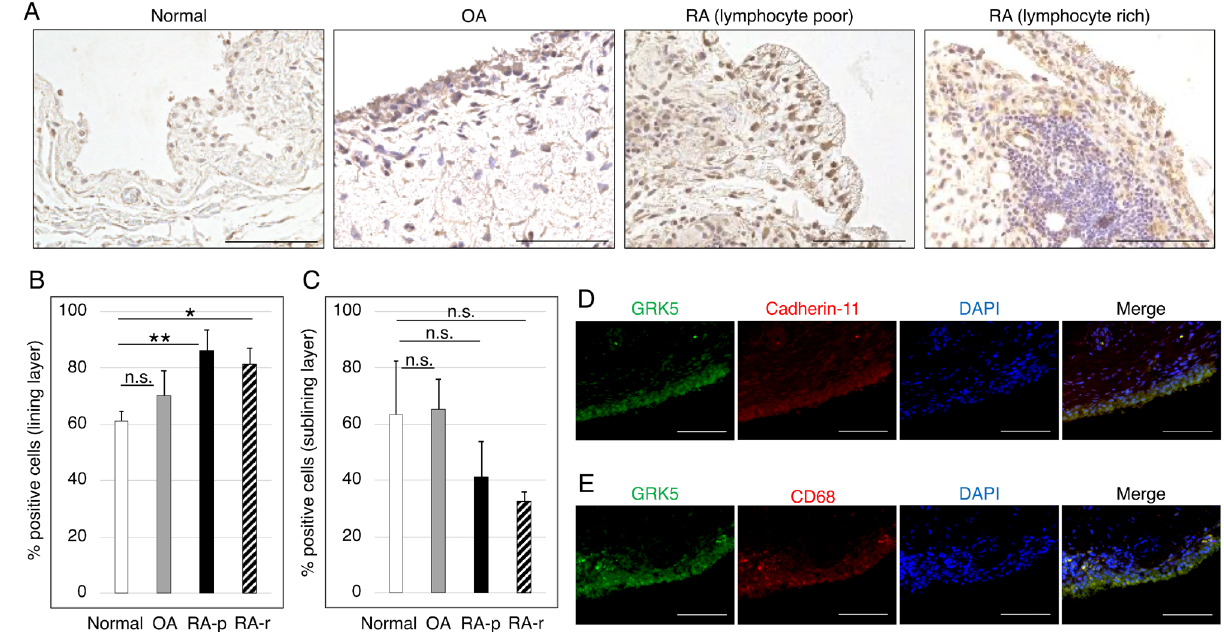
Figure 1. GRK5 expression in human synovium. ( A ) Representative immunohistochemical staining for GRK5 in normal, OA, and RA synovium. RA synovium samples were divided into two groups due to subsynovial inflammatory infiltration; lymphocyte poor (RA-p) and rich (RA-r). Scale bar = 100 μm. ( B , C ) Quantification of GRK5-positive cells in the synovial ( B ) lining layer and ( C ) sublining layer of normal, OA, and RA